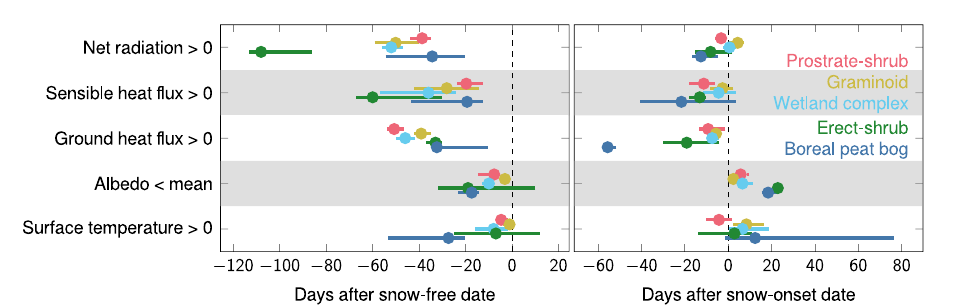
Fig. 3 | Timing of the summer-regime relative to the snow-free period for selected fl uxesandcomponentsofthesurfaceenergybudget(SEB). Numberof days difference between the start of the summer-regime period and the spring snow-freedate(leftpanel, x -axis)aswellasbetweentheendofthesummer-regime period and the autumn snow-onset date (right panel, x -axis). The summer-regime timings are derived from the smoothed seasonalities (mean±s.e., see Fig. 2) of selected surface energy fl uxes ( y -axis), for different vegetation types ( n =5 per surface energy fl ux), colored dots: prostrate-shrub tundra (light red), graminoid tundra (yellow green), wetland complex (light blue), erect shrub tundra (green),